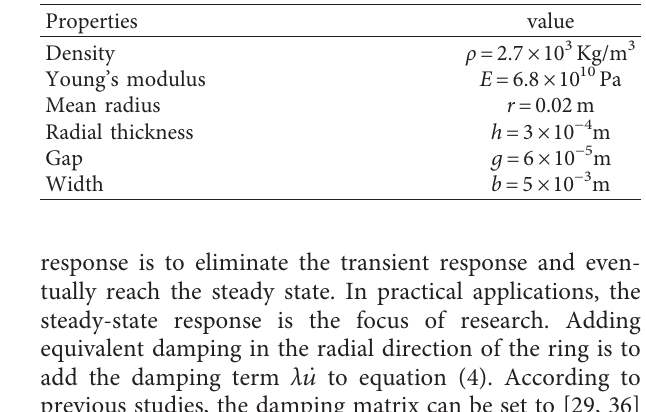
Table 1: Material parameters and geometric